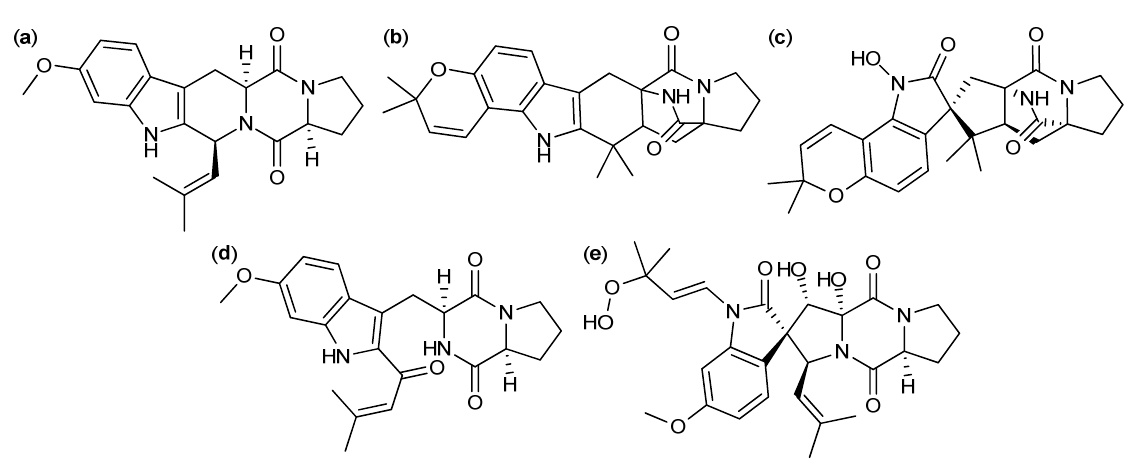
Figure 13. Tryptophan/proline diketopiperazines: ( a ) Fumitremorgin C, ( b ) Stephacidin A, ( c ) Notoamide A, ( d ) 18-Oxotryprostatin A and ( e ) Spirotryprostatin E.